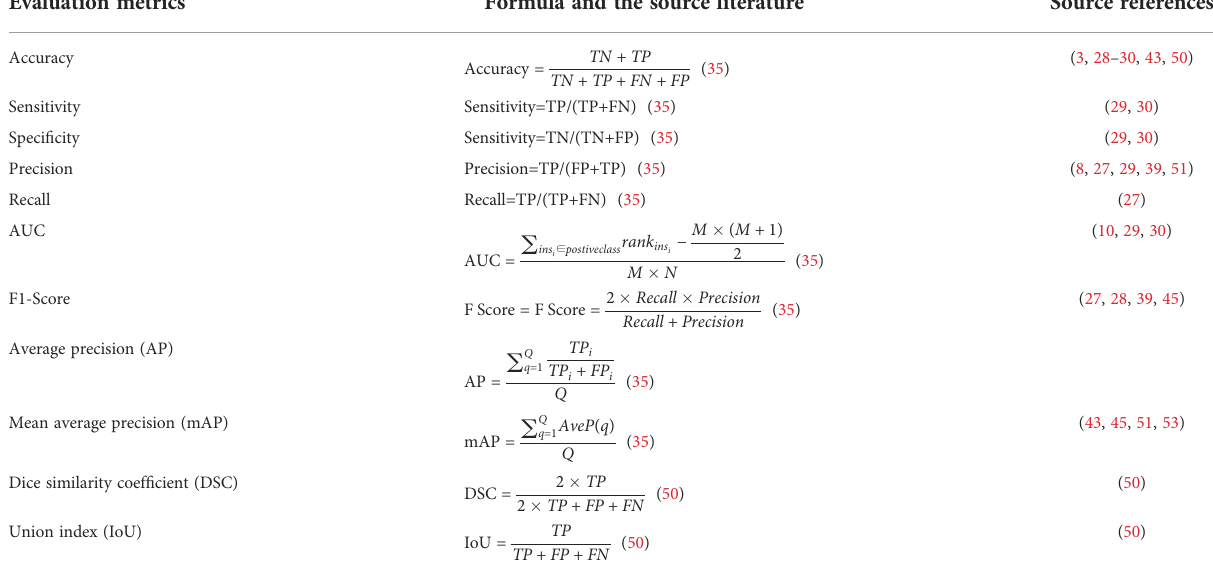
TABLE 4 Performance evaluation metrics used in the research of the above literature for deep learning in DFUs.